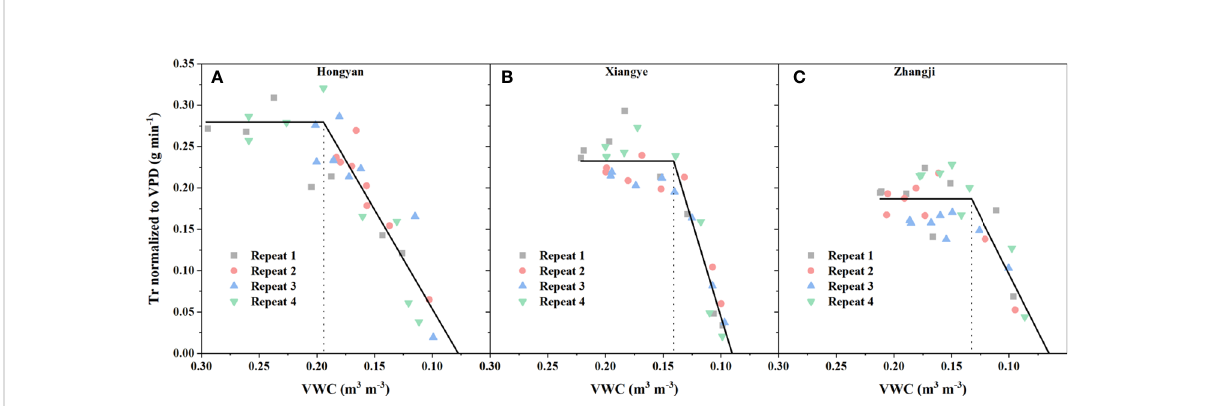
FIGURE 3 Midday Tr normalized to VPD (Tr m,VPD ) against soil water content (VWC) for different strawberry varieties. The Tr m,VPD and VWC data were both averaged between 12:00 and 14:00 and then fi tted with a piecewise function (Eq. 1). The in fl ection point of the fi tting curve was determined as the critical soil water content, i.e., q cri , below which Tr m,VPD decreased linearly. Three strawberry varieties, i.e., Hongyan (A) , Xiangye (B) and Zhangji (C) , were used in the